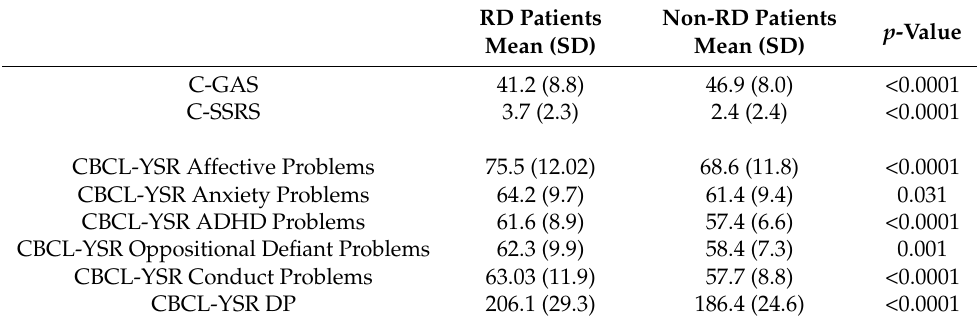
Table 2. Comparisons between Revolving Door and Non-Revolving Door patients on global func- tioning, suicidal risk, and behavioural and emotional